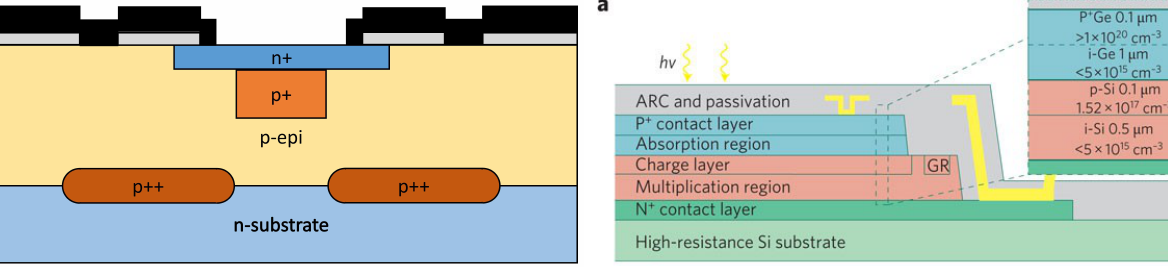
Figure 8: Dual junction, thin Si SPAD. The design is similar to the planar epitaxial design, except the low resistance p ++ layer is broken underneath the active region to allow for wider epis- trate/substrate depletion region. From [42].